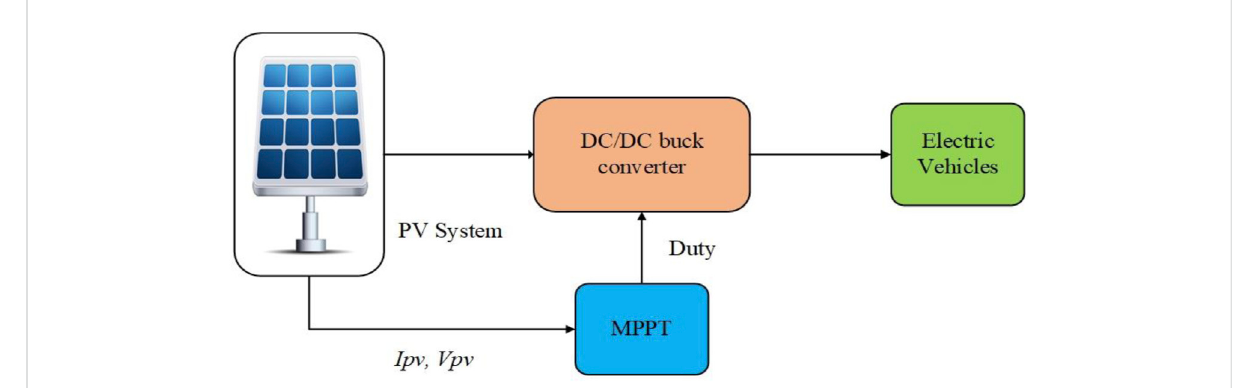
FIGURE 7 Block diagram of the PV system with P&O MPPT.